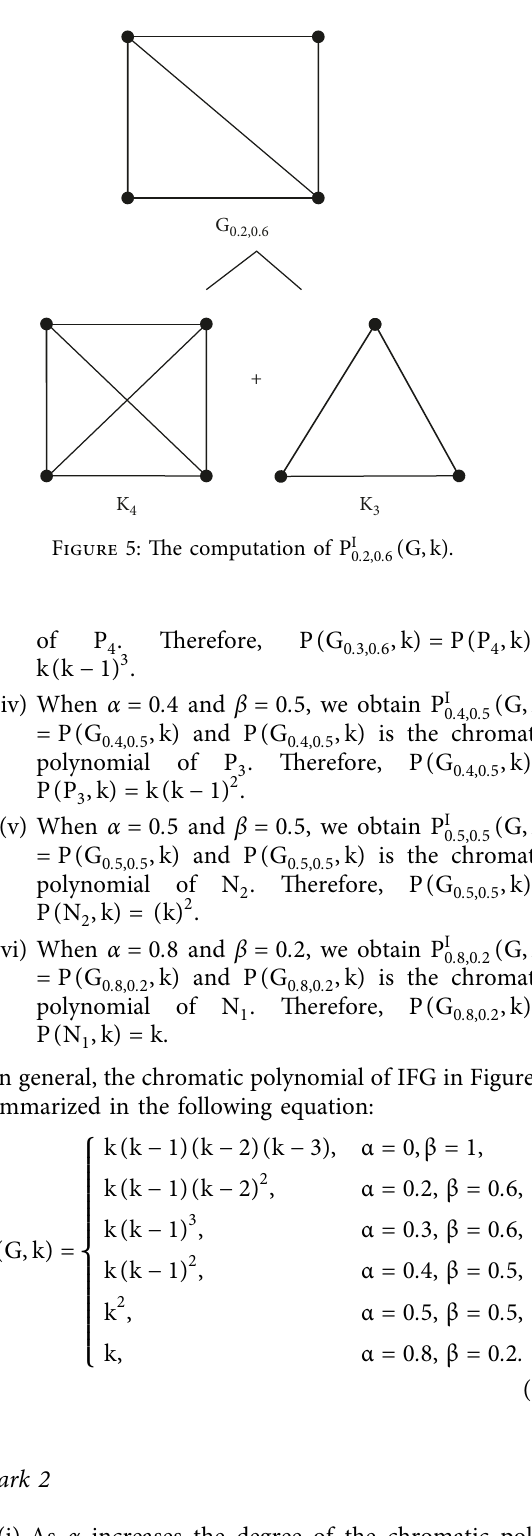
Figure 5: The computation of P I